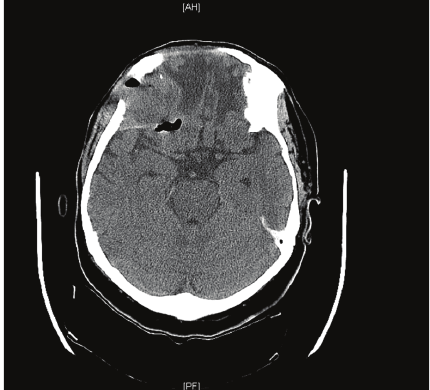
Figure 2: Noncontrasted CT demonstrating brain abscess and